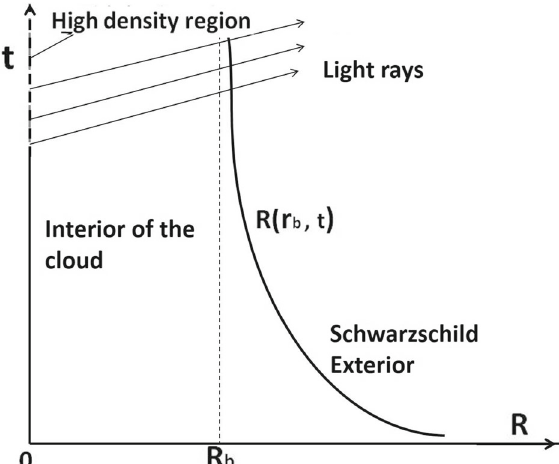
Fig. 4 The equilibrium configuration is achieved asymptotically and settles to a final radius. The central density becomes very large and tends to singularity in infinite comoving